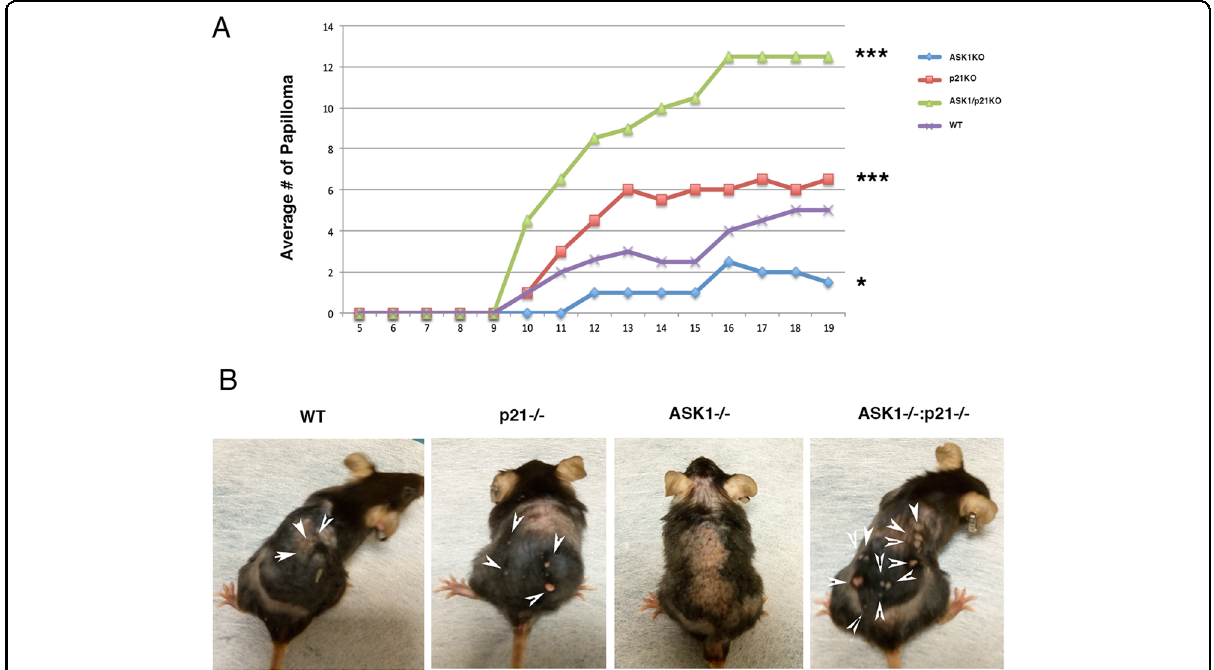
Fig. 4 Inactivation of both p21 and ASK1 has a major impact on DMBA/TPA-induced carcinogenesis. A In vivo DMBA/TPA induces skin carcinogenesis in 7 – 9 week old mice. Upper panel the indicated mice were treated once with DMBA (100 μ g in 200 μ l of acetone) and then continually treated with TPA (10 μ g in 200 μ l of acetone) twice a week for 20 weeks. The average (8 mice each group) number of papillomas per mouse is shown. The signi fi cance of the differences was calculated using one-way ANOVA. * P < 0.05, *** P < 0.0005 are the signi fi cance of indicated mice compared with WT mice. B Lower panel, a representative picture of the treated mice.